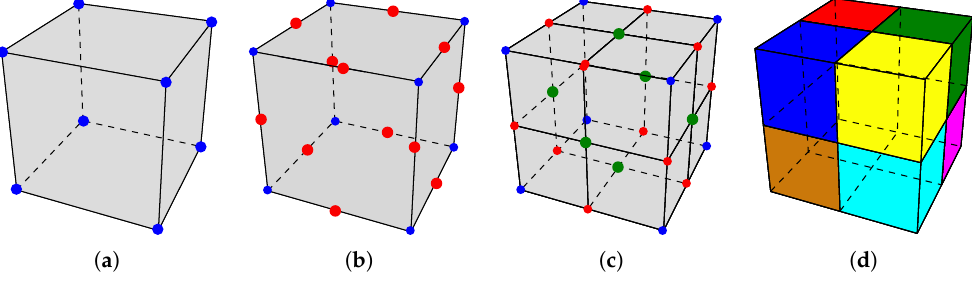
Figure 3. Hexahedral subdivision 1:8. ( a ) Initial hexahedron. ( b ) Split each edge in two. ( c ) Split each face in four. ( d ) Split the hexahedron in